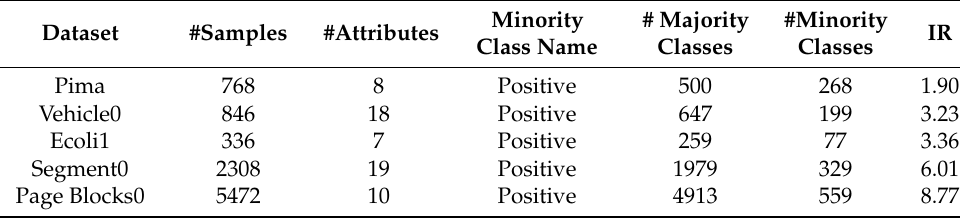
Table 2. Characteristics of datasets used for experimentation and validation.